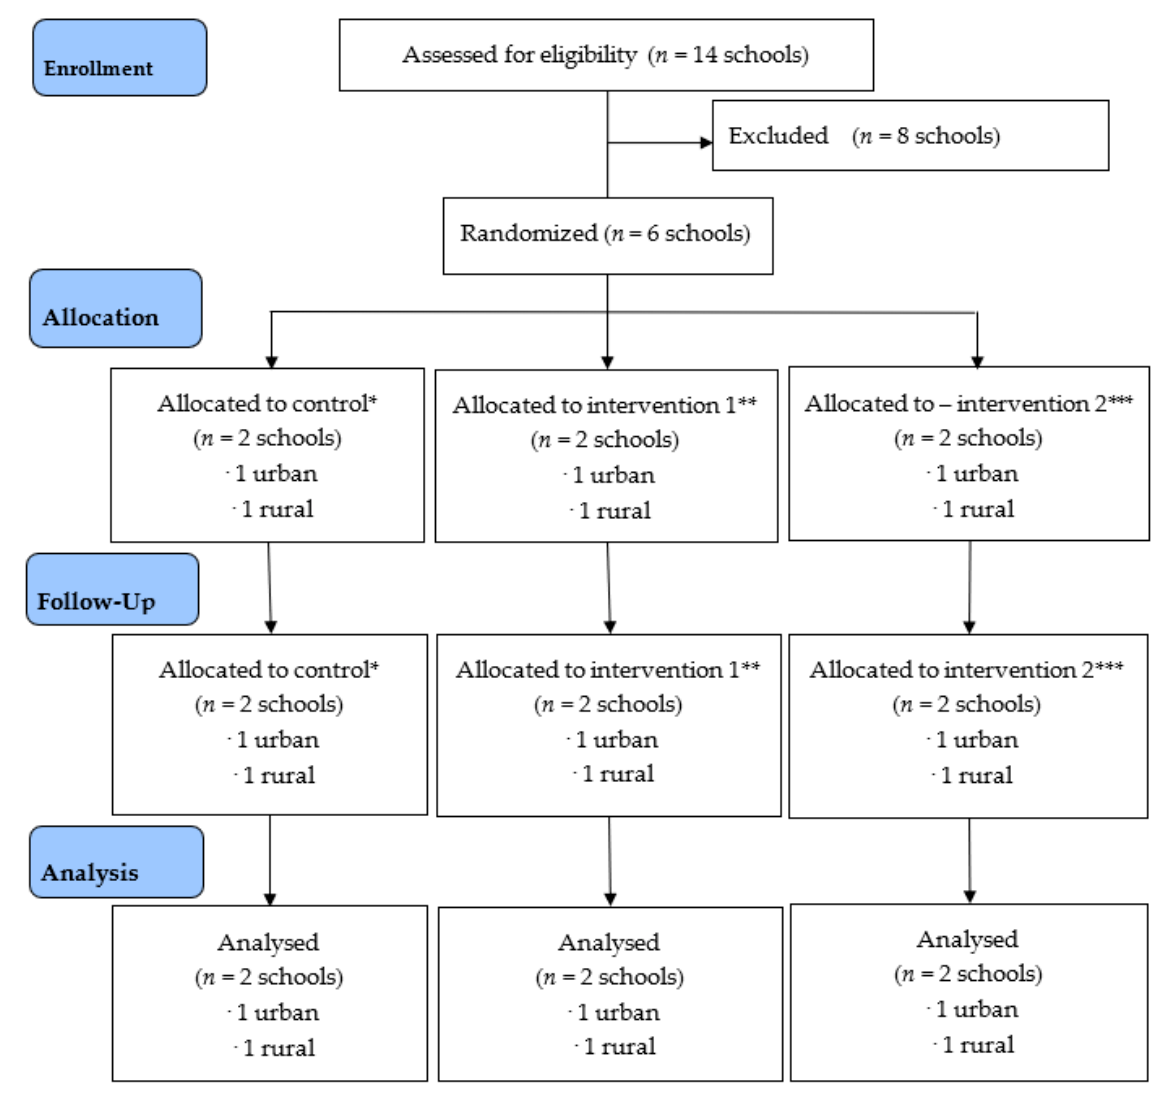
Figure 1. The CONSORT Flow diagram of MyHeART BEaT study. * Control: No intervention. The canteen and convenience shop operators continued their usual approach based on healthy canteen guidelines by MoH. ** Intervention 1: Training only. Training on healthy cooking methods, the na- tional healthy eating policy, nutrition, and change management of the canteen and school conven-